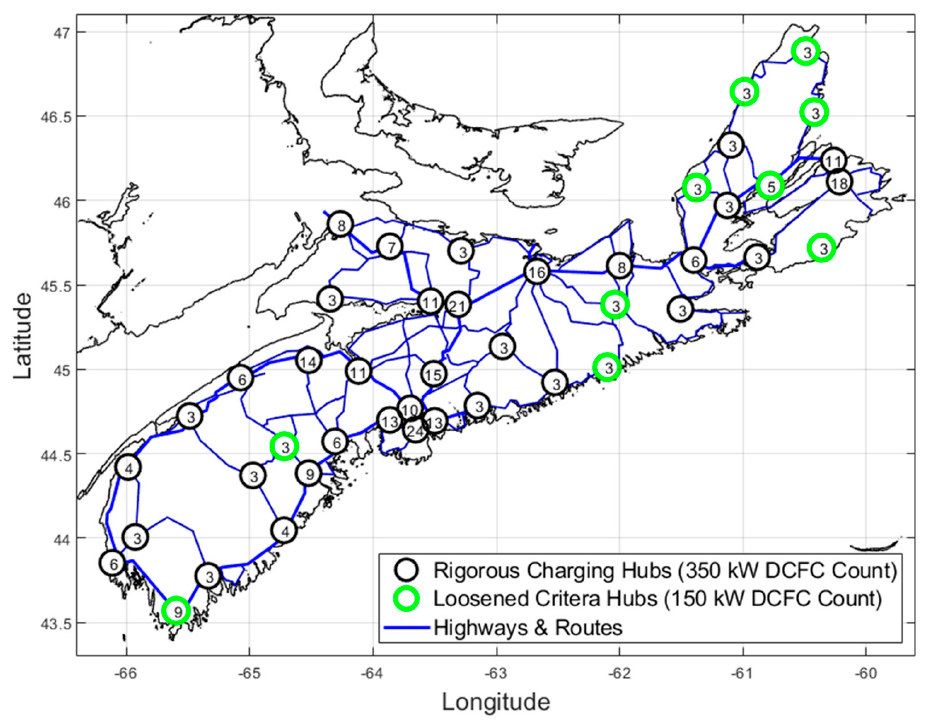
Figure 5. Charger counts at 350 kW (or 150 kW, green) each, at each hub location to support 15% EV fleet fraction.